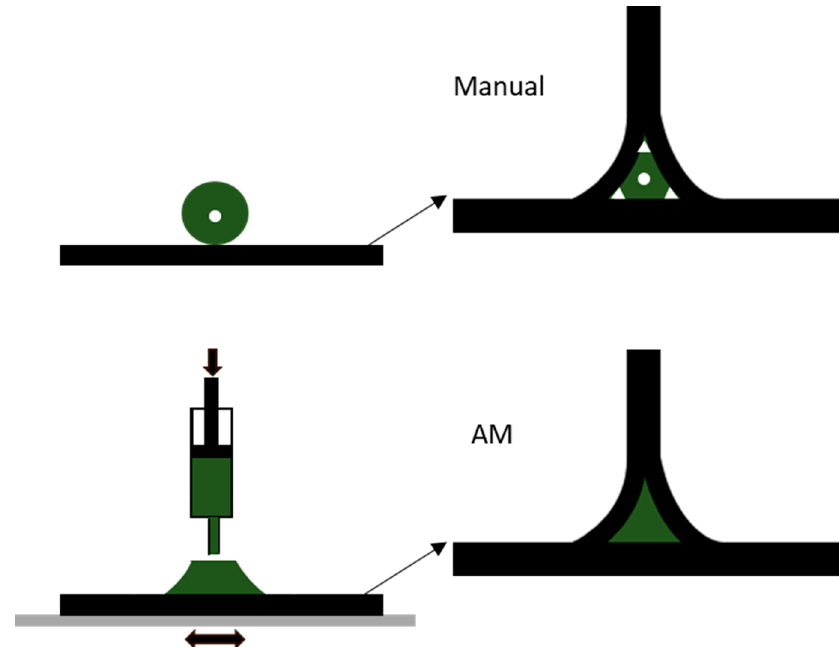
Figure 8. Manually pre-shaped deltoid vs. an AM processed pre shaped deltoid. AM T-joints have better geometrical accuracy and less porosity.